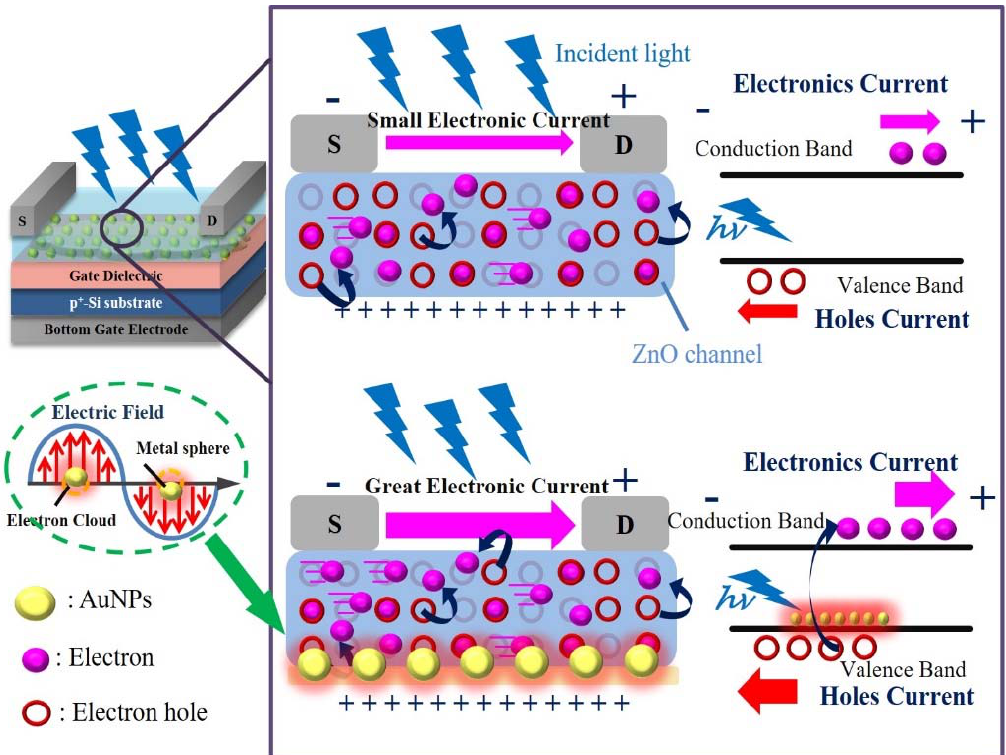
Figure 7. The ZnO ‐ based TFTs incorporated with AuNPs that induced surface plasmon resonance Figure 7. The ZnO-based TFTs incorporated with AuNPs that induced surface plasmon resonance when they absorbed the 520 nm wavelength of light when they absorbed the 520 nm wavelength of light illumination.